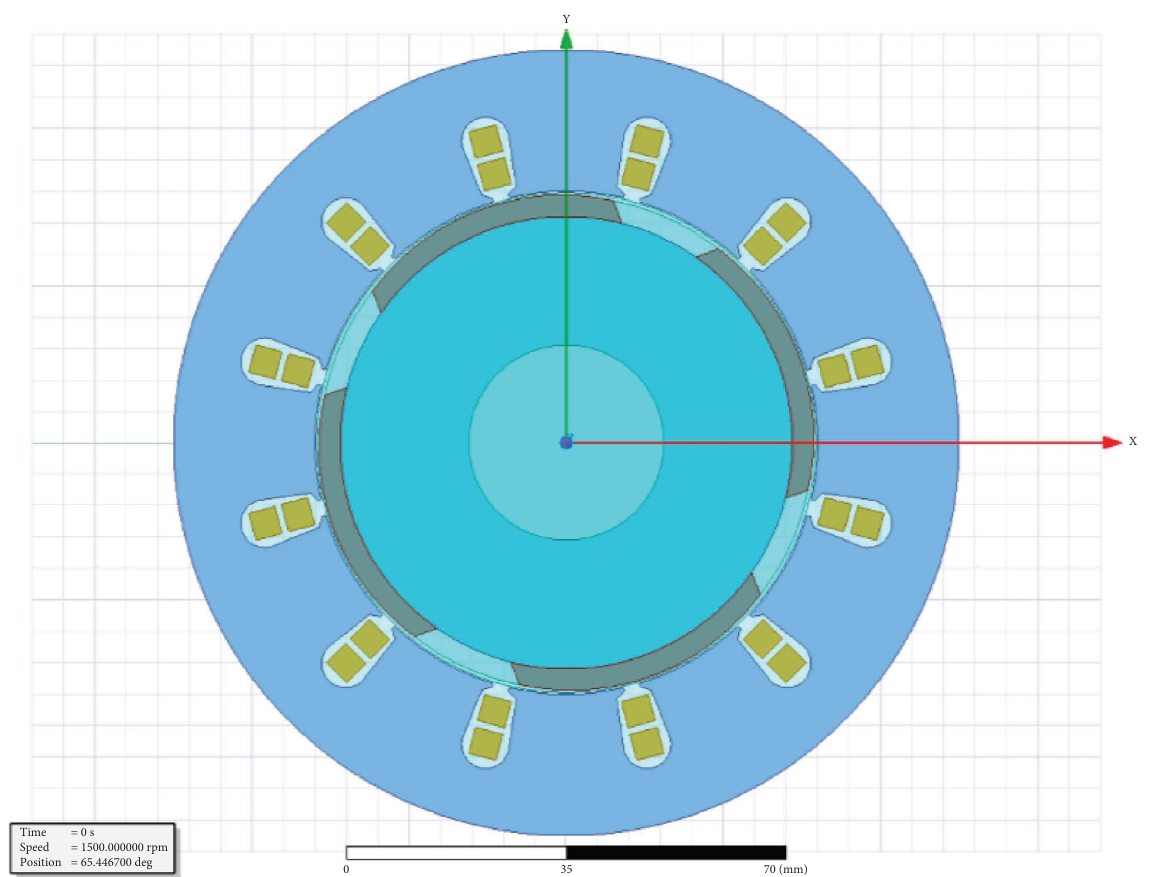
Figure 1: Topology of 4-pole 12-slot